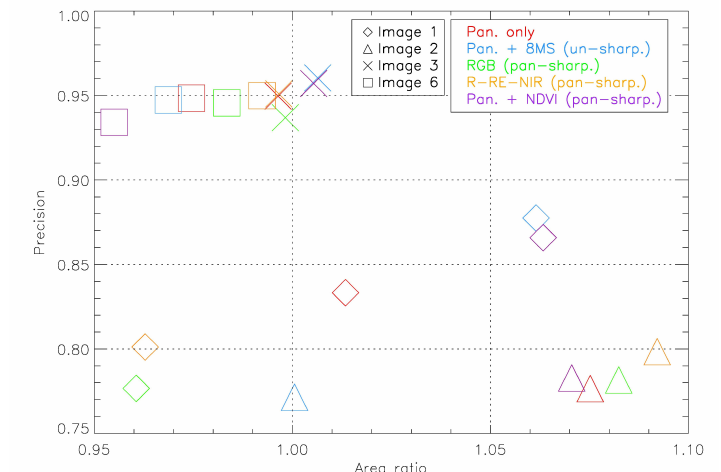
Figure 9. Comparison of precision and area ratio for different images (symbol type) and models (symbol color). There is no clear relationship between model parameters and area ratio, suggesting it is more strongly related to the image characteristics. Image 1 shows the largest variation in area ratio performance between